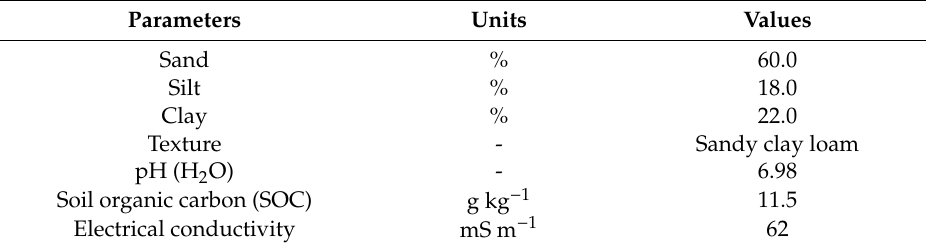
Table 1. Some of the experimental site characteristics in the top 0.1 m soil depth (Source: